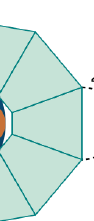
Figure 3. The initial step for a circular scenario is shown on the left. On the right, different fields of view are shown for the agent at the center on the left image. Its horizontal field of view varies from 90 ◦ to 360 ◦ , and the vertical angle fixed to 80 ◦ .